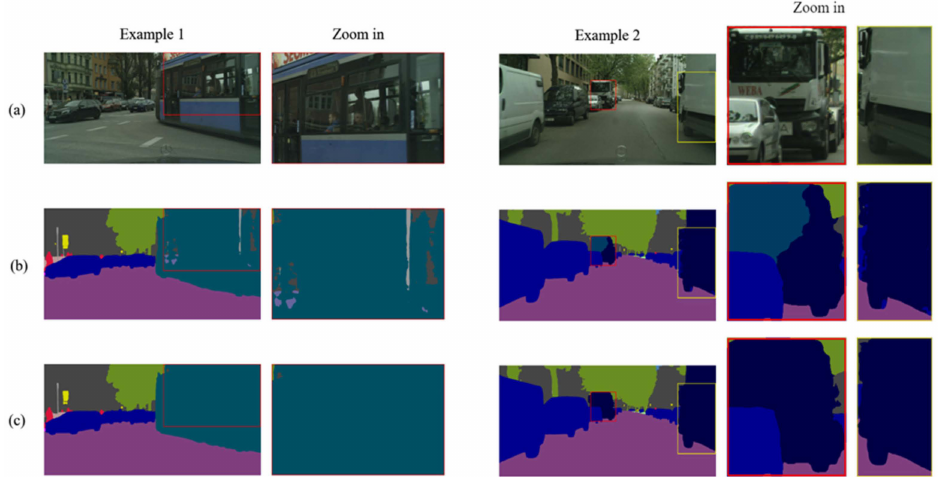
Figure 6. ( a ) Input image and results of the ( b ) ResNet-18 backbone [28] and the ( c ) HarDNet- 68ds [37]